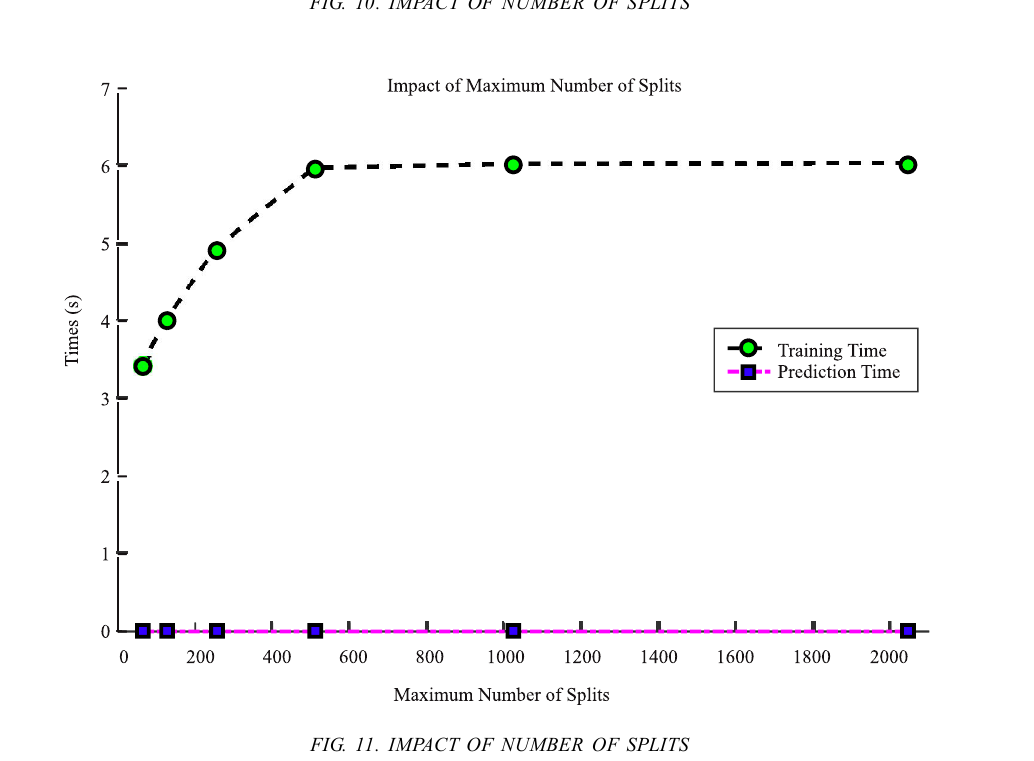
FIG. 11. IMPACT OF NUMBER OF